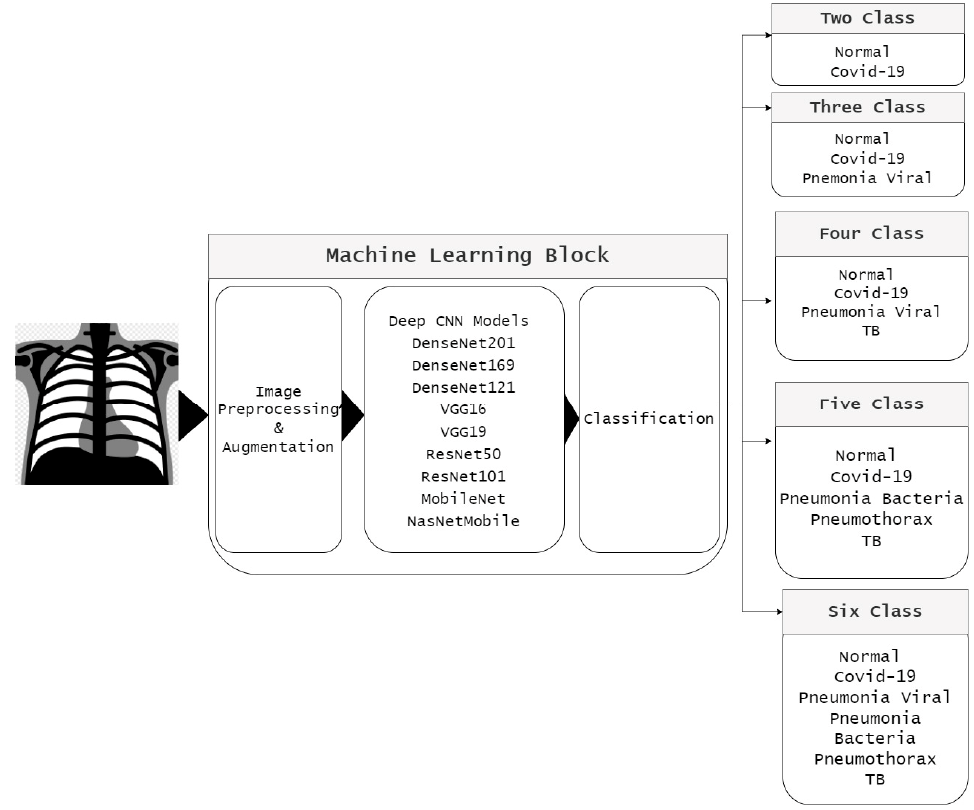
Figure 2. Pipeline of proposed model.